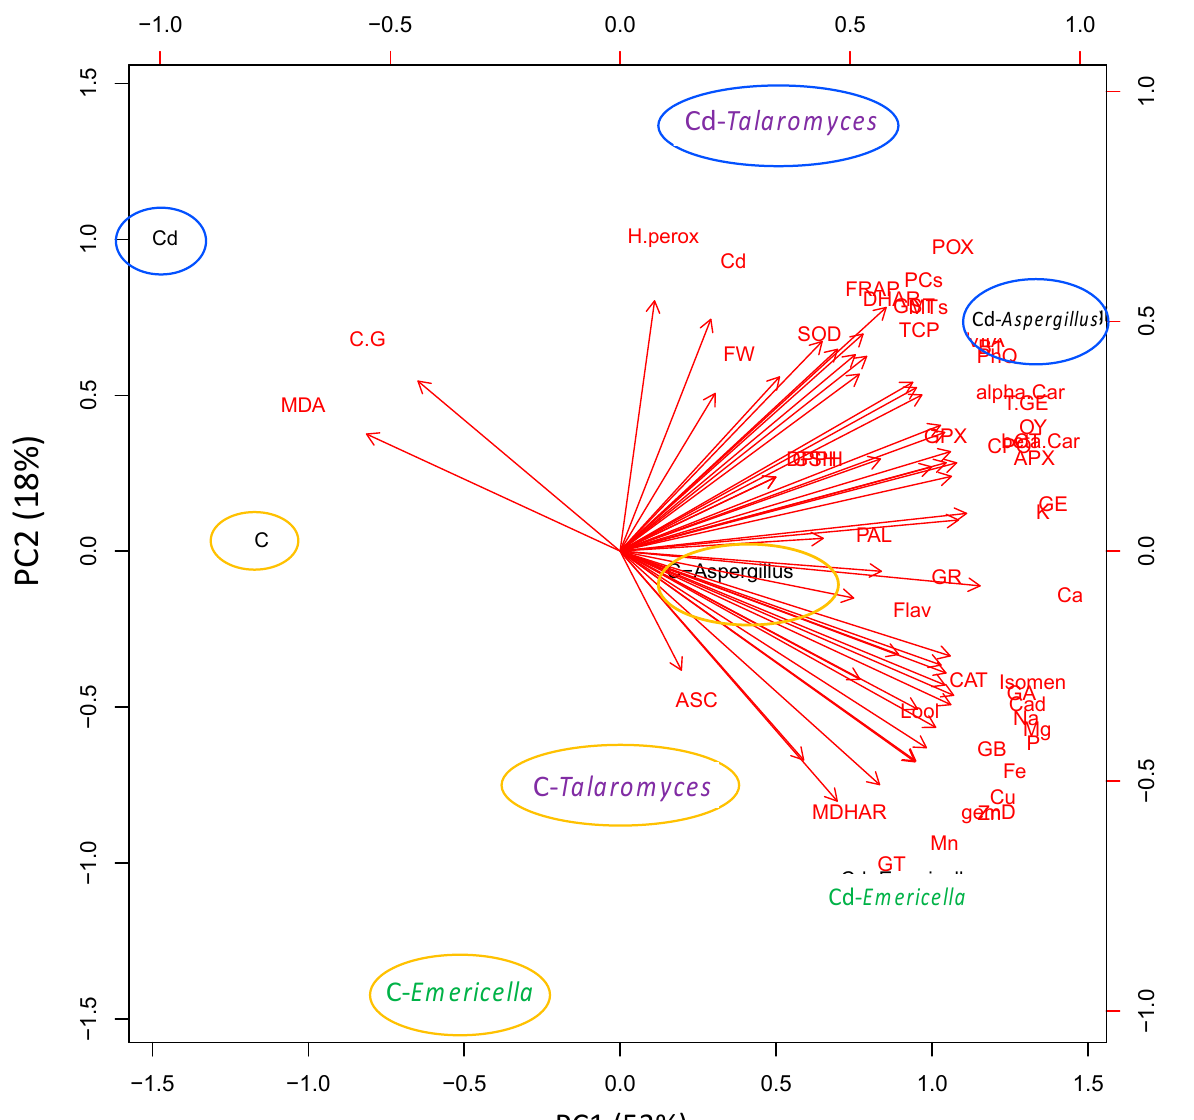
Figure 5. Principle component analysis (PCA) of growth and biochemical parameters of geranium leaves as affected by the inoculation with different endophytic fungi; T . versatilis (E6651), E . nidulans (E6658), and A . niger (E6657) under normal conditions and Cd-stress. C; non-inoculated geranium under normal conditions, C- Talaromyces , C- Emericella and C- Aspergillus; geranium inoculated with different endophytic fungi under normal conditions, Cd; non-inoculated geranium under Cd-stress, Cd- Talaromyces , Cd- Emericella and Cd- Aspergillus; geranium inoculated with different endophytic fungi under Cd-stress, FW; leaves fresh weight, H perox; hydrogen peroxide, MDA; lipid peroxidation, SOD; superoxide dismutase, CAT; catalase, POX; peroxidase, APX; ascorbate peroxidase, MDHAR; monodehydroascorbate reductase, DHAR; dehy- droascorbate reductase, GR; glutathione reductase, GPX, glutathione peroxidase, DPPH; 1,1-diphenyl-2-picrylhydrazyl, FRAP; ferric ion reducing antioxidant power, PAL; phenylalanine ammonia-lyase, Flav; flavonoids, GST; glutathione S- transferase, GSH; glutathione, PCs; phytochelatins, MTs, metallothioneins, VitA; β -cryptoxanthin, alpha-Car; α -carotene, beta-Car; β -carotene, B1; thiamine, PhQ; phylloquinone, ASC; ascorbic acid, TCP; tocopherols, CT; citronellol, T.GE; trans- geraniol, Isomen; isomenthone, Lool; linalool, GA; geranylacetate, Cad; cadinene, GB; geranyl butyrate, GT; geranyl tig-